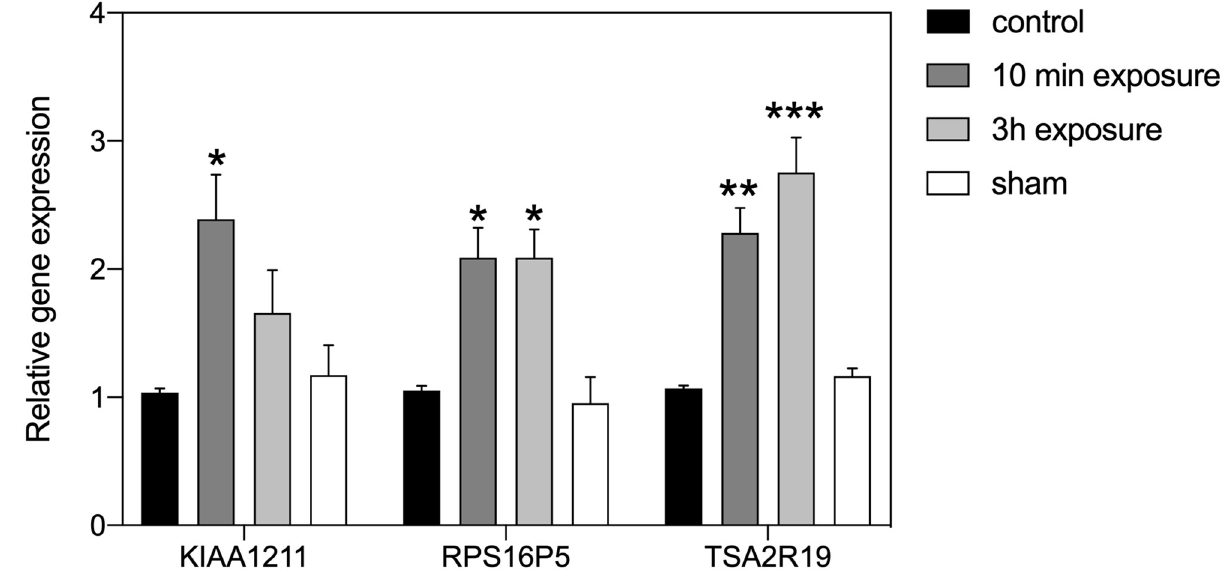
Fig 1. Effect of low level field (LLF) on HEK293 gene expression. The expression level of genes KIAA1211, RPS16P5 and TAS2R19 after exposure to LLF condition for 10 min (dark-grey bar) or 3h (light-grey bay) in comparison to the Control (black bar) or sham-exposed (white bar) condition. The ‘Control’ condition represents growth in the incubator at the local geomagnetic field without added applied static field. The ‘Sham’ condition was a 40 μ T field produced by Helmholtz coils placed inside the Mu-metal cylinder used to generate the LLF to mimick the geomagnetic field (see methods). Data are shown as mean ± SE of three independent experiments (N = 3). The asterisks indicate significance level of the differences: � p -value < 0.1; �� p - value < 0.01; ��� p -value < 0.01.